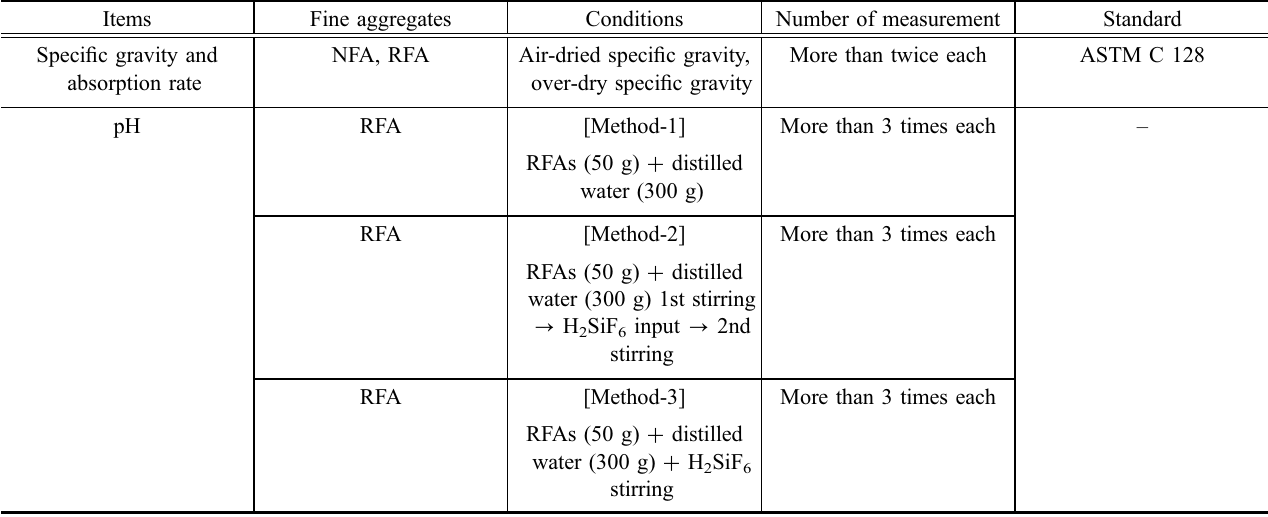
Table 5 Test items and methods (RFAs) (ASTM International